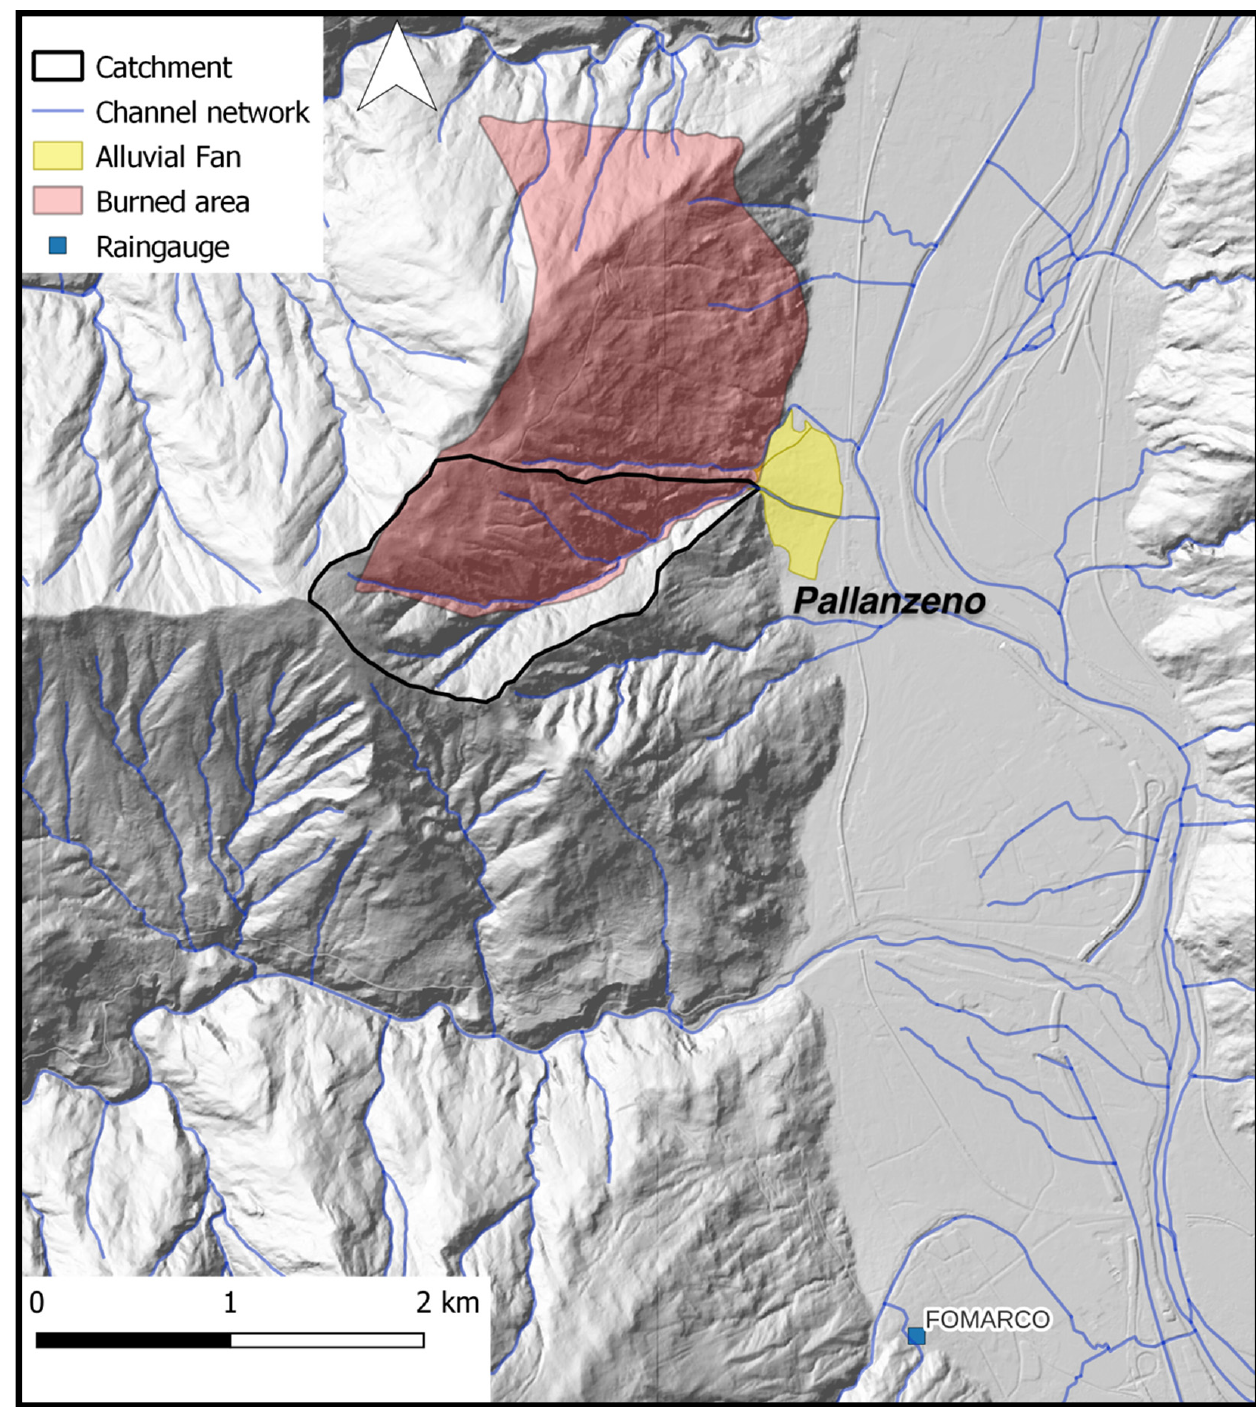
Figure 3. Map shows the delimitation of wildfire involving the Rio Casella catchment and nearest raingauge (Fomarco weather station).